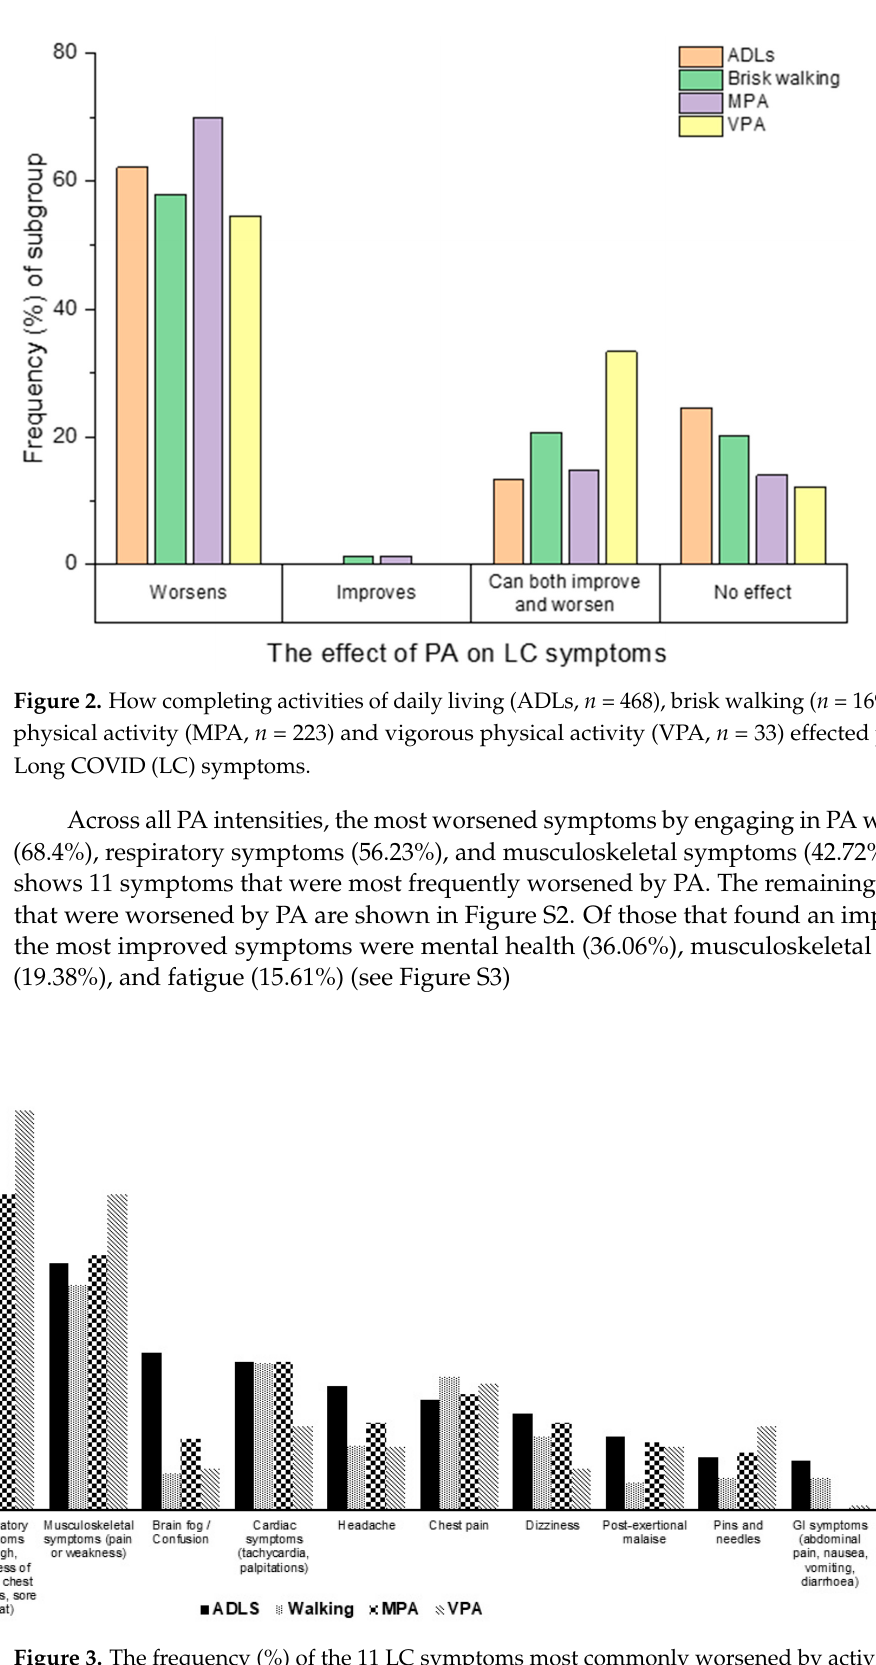
Figure 3. The frequency (%) of the 11 LC symptoms most commonly worsened by activities of daily living (ADL, n = 353), brisk walking ( n = 133), moderate physical activity (MPA, n = 189) and vigorous physical activity (VPA, n = 29).